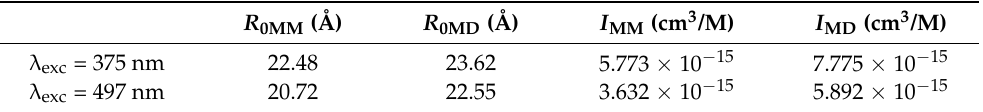
Table 6. Overlap integrals I MM and I MD of the monomer fluorescence spectrum (for C = 7 × 10 − 5